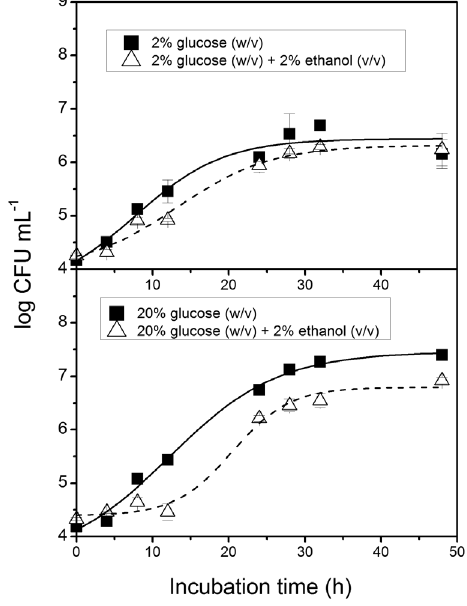
FIGURE 4 - Growth curves of S. cerevisiae strain NCYC 240 cultured in media containing 2 % (w/v) and 20 % (w/v) glucose, in the presence and absence of 2 % ethanol (v/v).